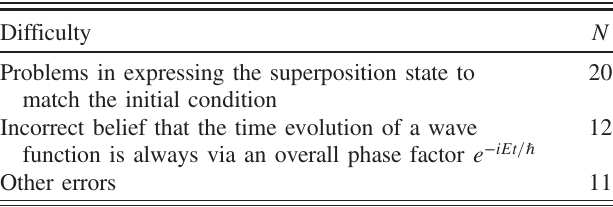
TABLE VII. Difficulties in step C3: setting up expressions to match the boundary